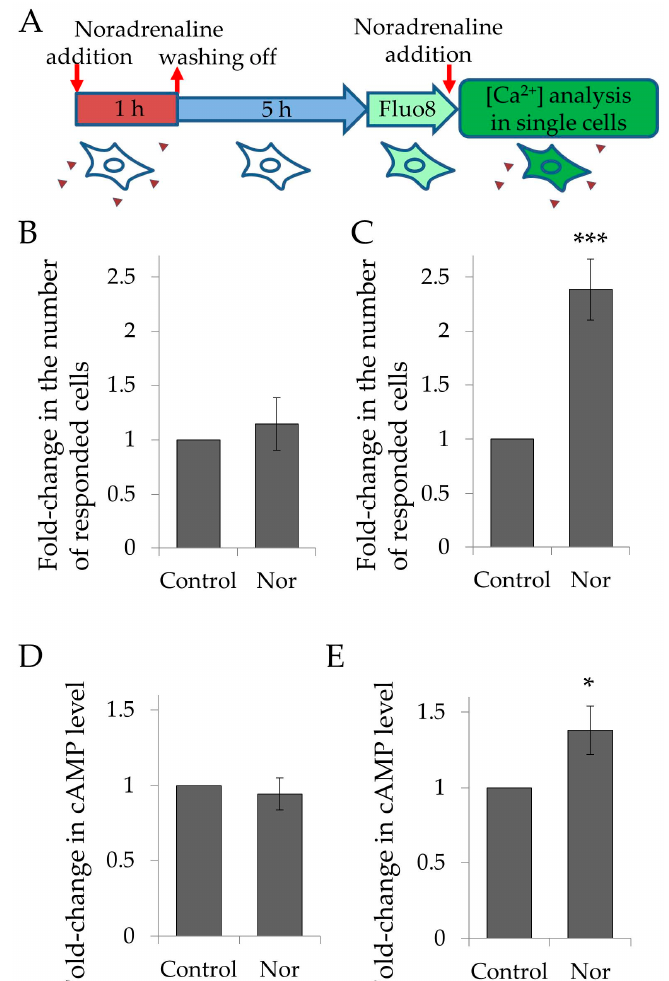
Figure 4. hTERT-MSCs demonstrated impaired regulatory mechanisms of noradrenaline-dependent intracellular signaling. ( A ) Scheme of experiments measuring heterologous sensitization in adMSCs. ( B ) and ( C ) Heterologous sensitization in hTERT-MSCs and in primary adMSCs, respectively. Cells were treated with noradrenaline for 1 h and responsiveness was measured 6 h later. Control-cells were treated with growth medium; Nor-cells were treated with 10 − 6 M noradrenaline. ( D ) and ( E ) Noradrenaline-induced changes in cAMP level measured ELISA-based assay in hTERT-MSCs ( D ) and in primary adMSCs ( E ). Control-cells were treated with growth medium; Nor-cells were treated with 10 − 6 M noradrenaline for 15 min. Mean ± SEM, comparison was performed by Mann–Whitney U-criteria (M-U test) because of not normally distribution of the data, n = 12 for ( B ), n = 8 for ( C ), n = 8 for ( D ), n = 4 for ( E ). * p < 0.05, *** p < 0.001.